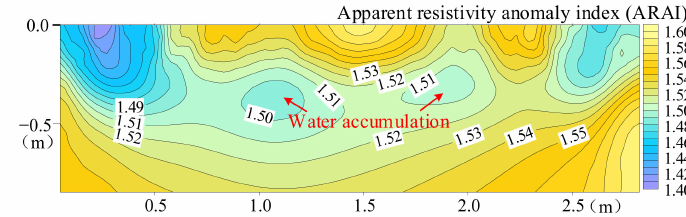
Figure 8. ARAI profile of the overlying strata.